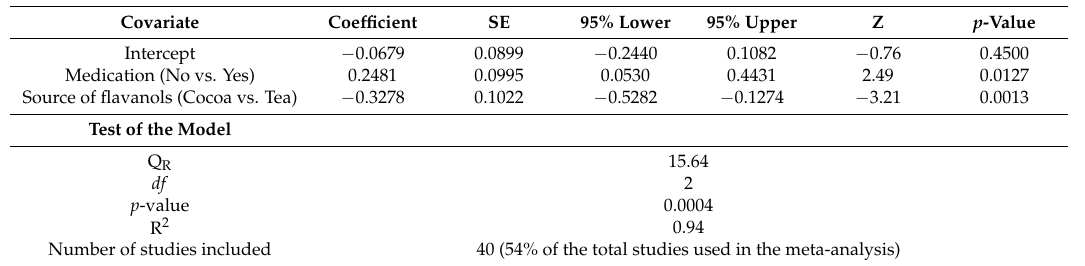
Table 6. Main results of the multiple random-effects meta-regression model for the contribution of the covariates, medication and source of flavanols, on BMI response (Standardized difference in